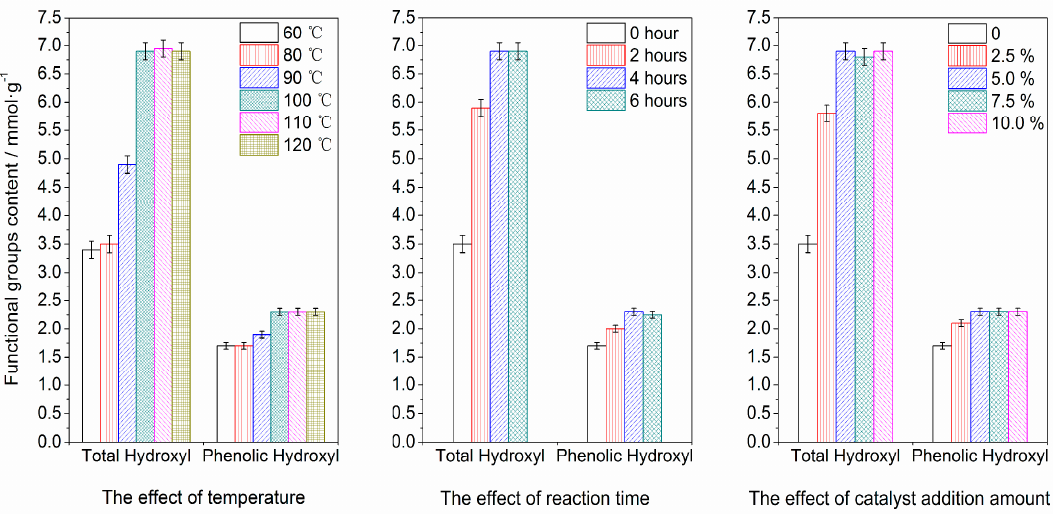
Figure 3. The e ff ects of reaction conditions on the degradation Figure 3. The effects of reaction conditions on the degradation reaction.